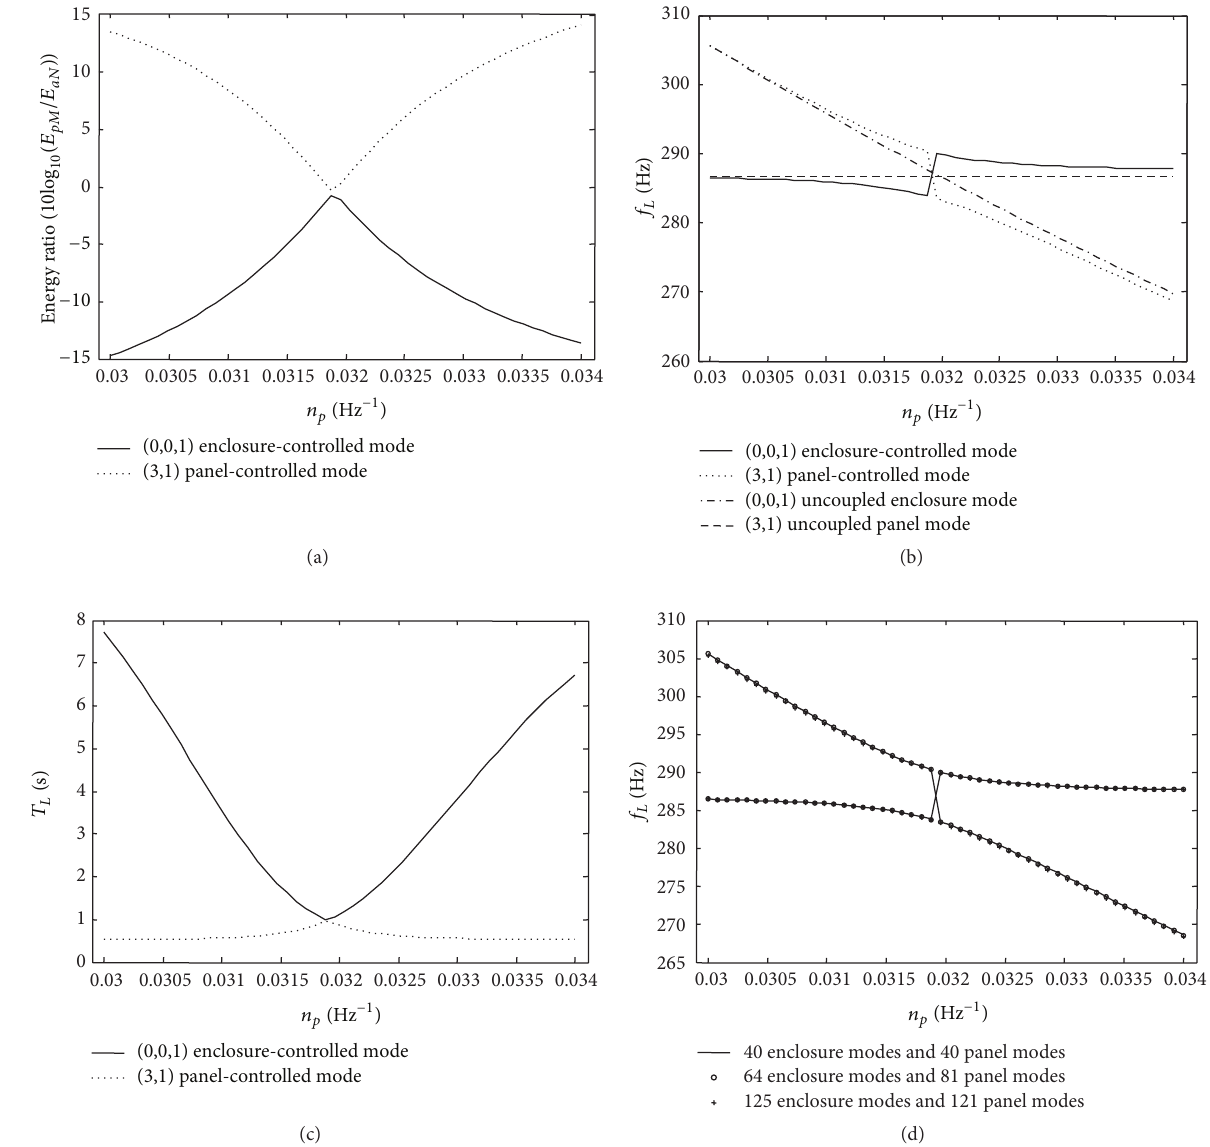
Figure 4: (a) Ratio between the sound field energy and panel vibration energy for two acoustical modes: (0,0,1) enclosure-controlled mode and(3,1)panel-controlledmode.(b)Resonancefrequenciesoftwoacousticalmodes,the(0,0,1)uncoupledenclosuremode,andthe(3,1)panel mode. (c) 60dB modal decay time 𝑇 𝐿 . (d) Resonance frequencies of two acoustical modes with different truncation numbers. 𝐿 𝑍 = 0.6 m, = 0.5 s, 𝑇 = 15 𝑇 𝑝𝑀 𝑎𝑁